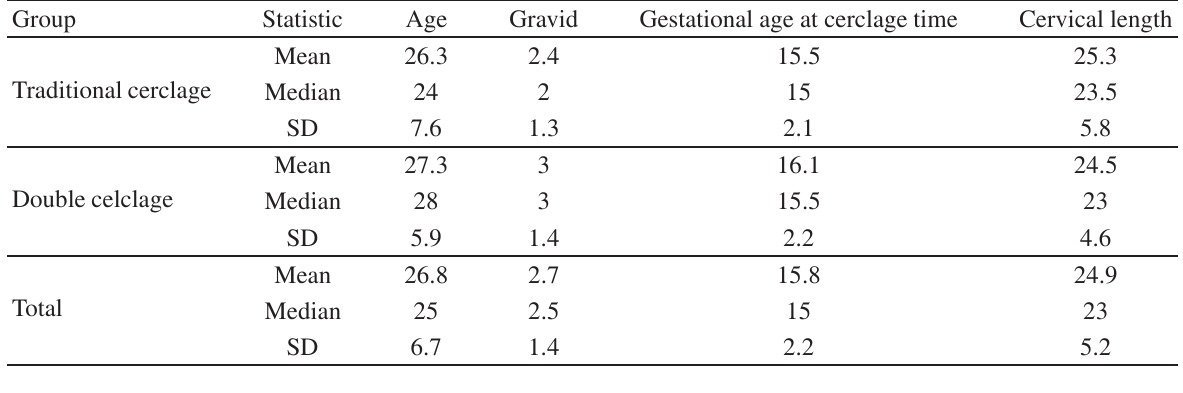
TABLE 1: Age, gravid and gestational age before cerclage compared between trial groups.